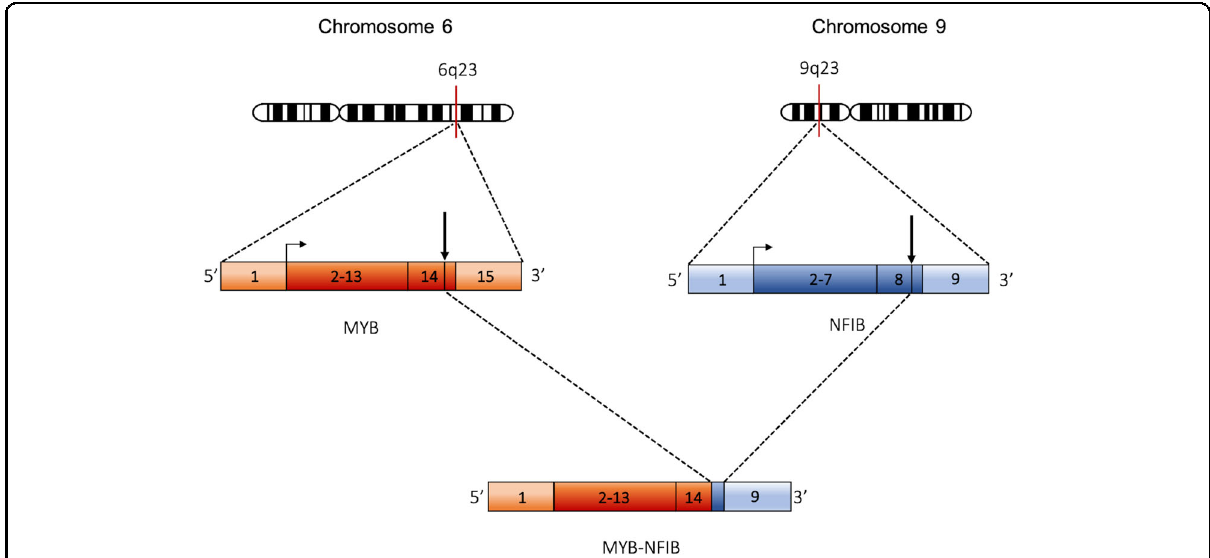
Fig. 2 Schematic illustration of the MYB-NFIB fusion gene. The t(6;9) translocation results in a MYB-NFIB gene fusion. Arrows indicate the breaking points.